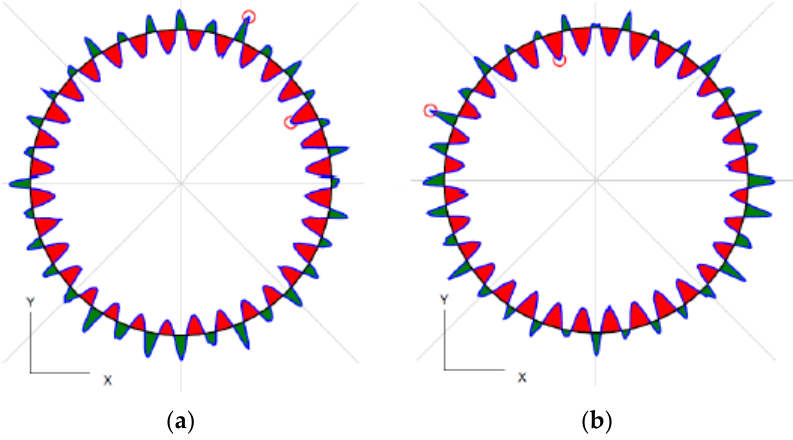
Figure 12. Roundness deviations ( a ) Constant Z strategy; ( b ) Circular Pocket strategy.